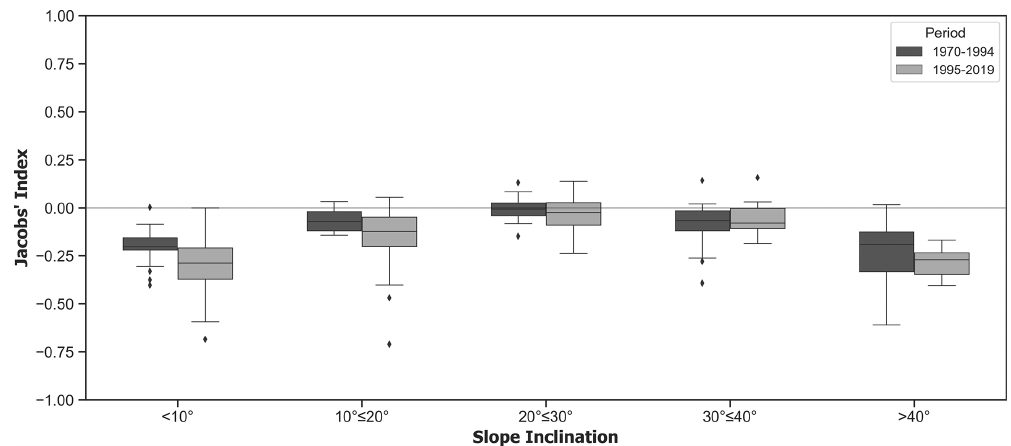
Figure 12. Box plot representing the distribution of the Jacobs’ index (ranging from − 1 to + 1) for 1970–1994 (left) and 1995–2019 (right), according to slope inclination. The (i) median value (50th percentile; bar within the box), (ii) first quartile (25th percentile; bottom part of the box), and (iii) third quartile (75th percentile; top part of the box) are shown. Whiskers represent observations outside the middle 50%, and points represent outliers.